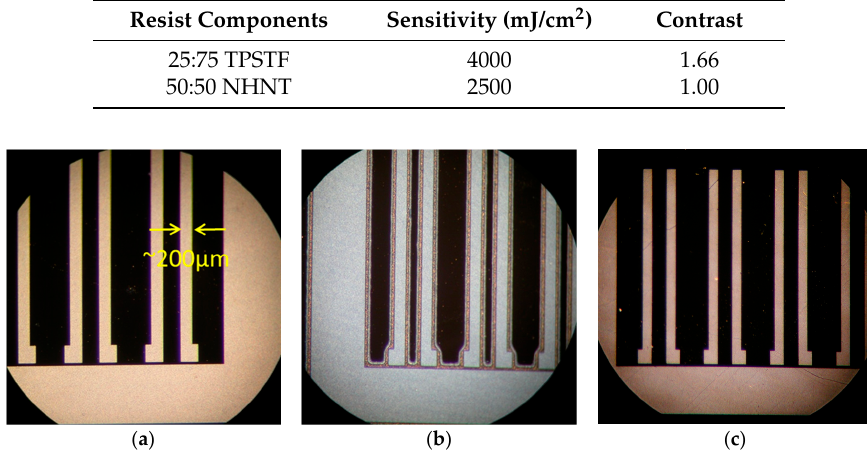
Figure 5. Optical microscope imaging of (L to R) 25:75 TPSTF; triphenylsulfonium triflate ( a ), 25:75 NHNT; N-hydroxynaphthalimide triflate ( b ), and 50:50 NHNT ( c ) resist blends. Table 1. Contrast and sensitivity data for UV mask aligner exposures.